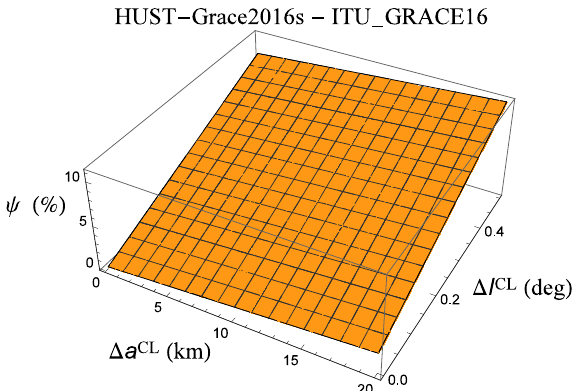
Figure A1. Percent systematic error ψ in the total L + CL Lense–Thirring node shift due to the mismodeling in J 2 calculated with Equation (6) as a function of ∆ a CL , ∆ I CL . The absolute value of the difference ∆ C 2,0 between the estimated values of C 2,0 of the HUST-Grace2016s [44] and ITU_GRACE16 [45] zero-tide models is assumed as representative of the uncertainty δ C 2,0 . Cfr. with